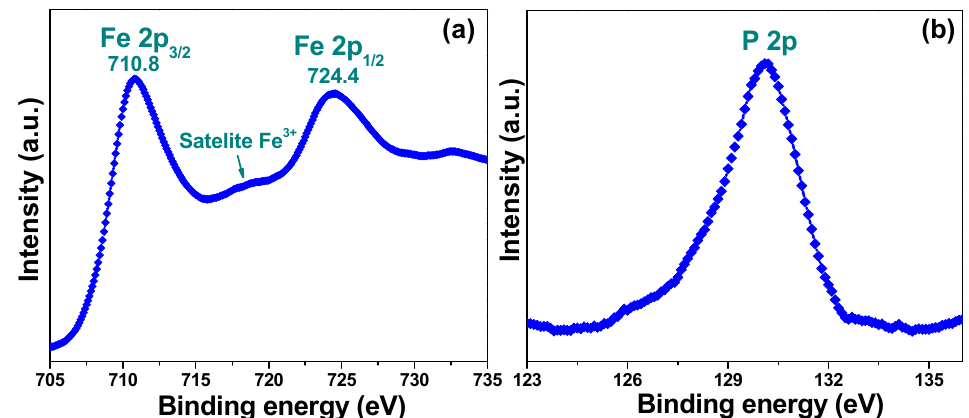
Figure 3. X-ray photoelectron spectra of the binding energies of the ( a ) Fe 2 p and ( b ) P 2 p core levels of the IB nanocomposite.